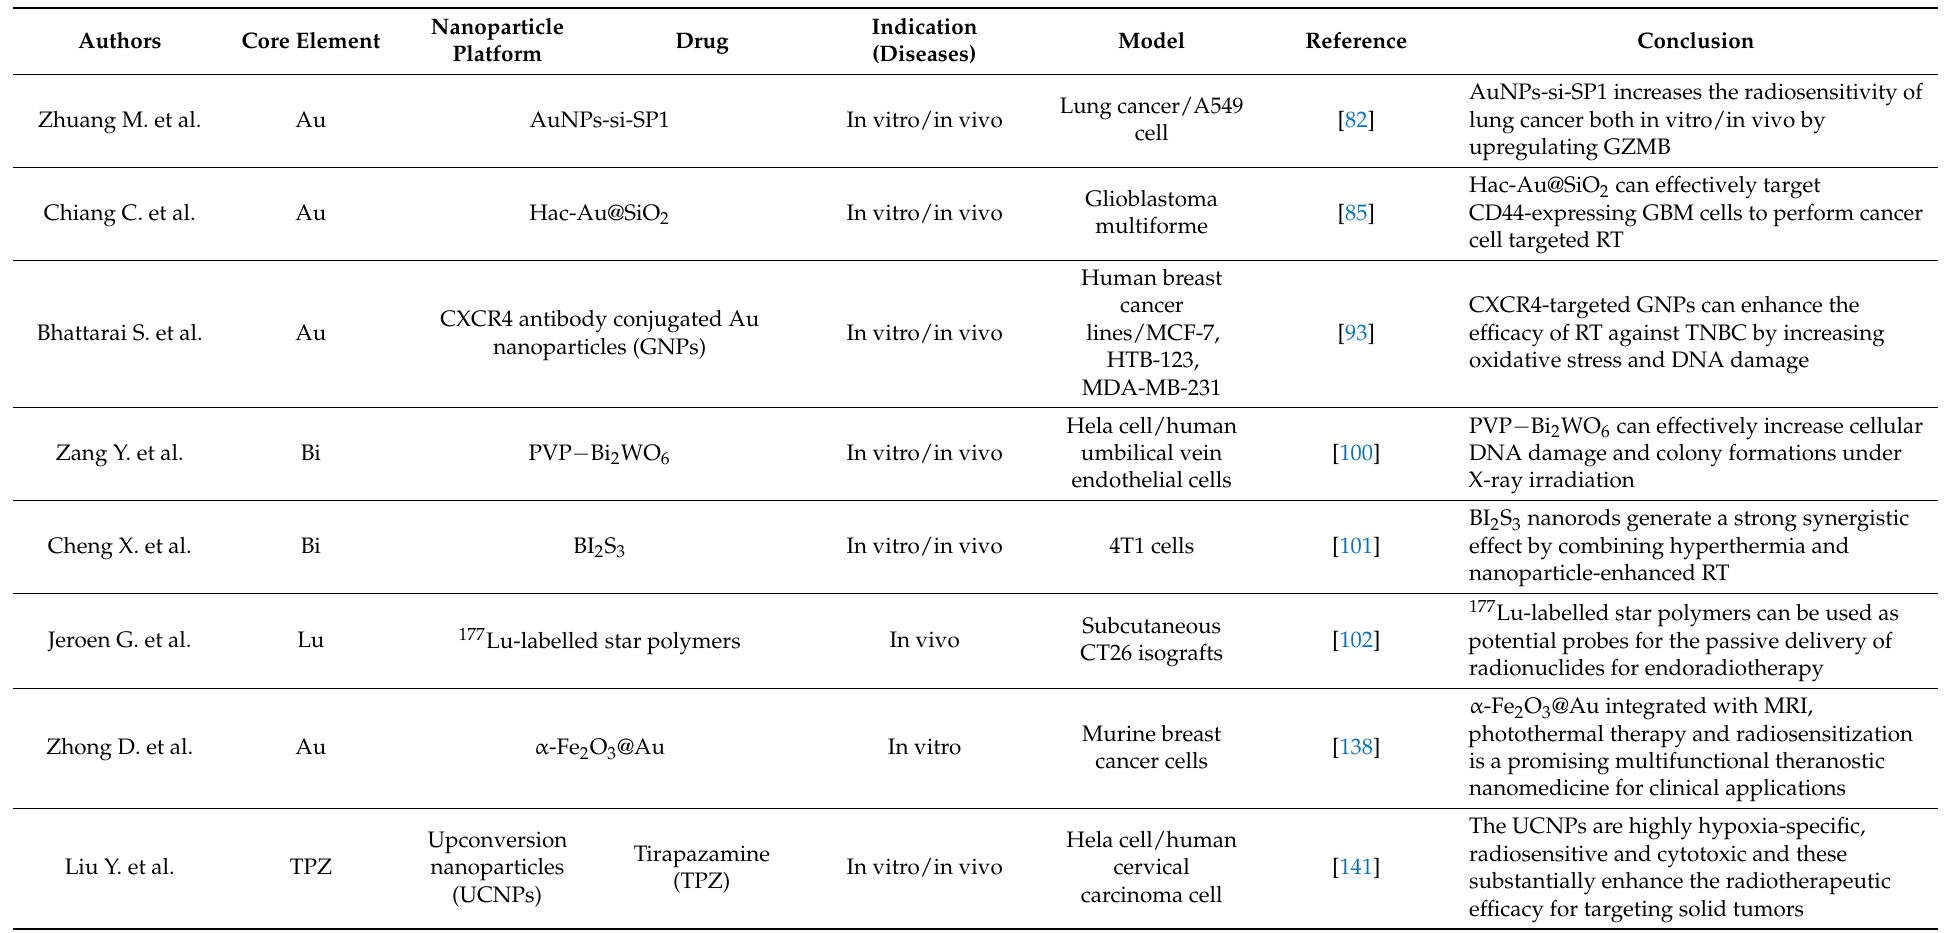
Table 1. Several studies delineated the significant implications of nanoparticles in the form of formulations in in vitro/in vivo models of cancers to enhance the efficacy of radiotherapy. ACF: acriflavine, Au: gold, Bi: bismuth, Lu: lutetium, Hf: hafnium, TPZ: